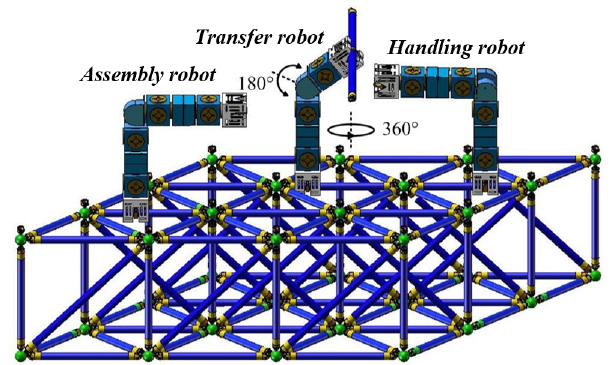
Figure 3. Space cell robot assembling truss in